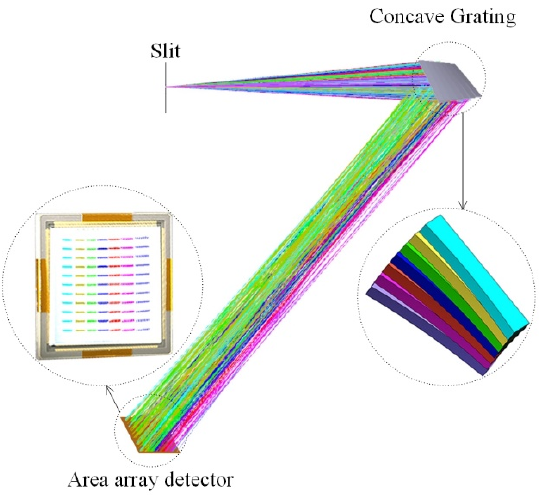
Figure 2. Structure of an integrated Paschen–Runge spectrometer.